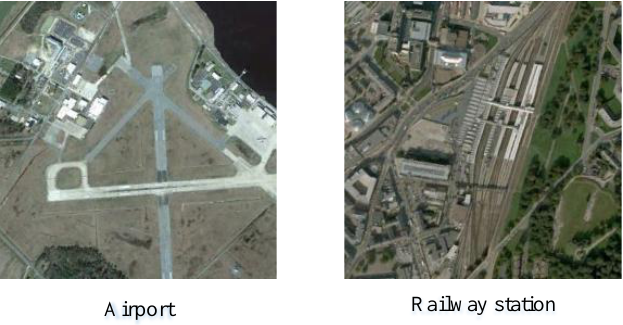
Figure 2. Airport scenario and railway station scenario.